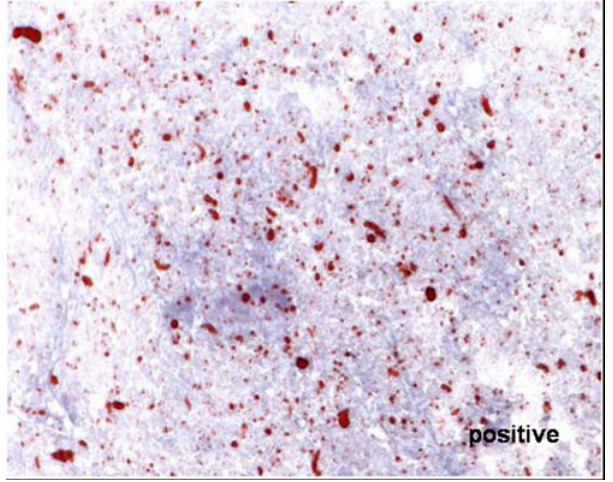
Figure 1. Picture of a positive result by the dRIT of a Chadian rabies sample, Magnification 400 6